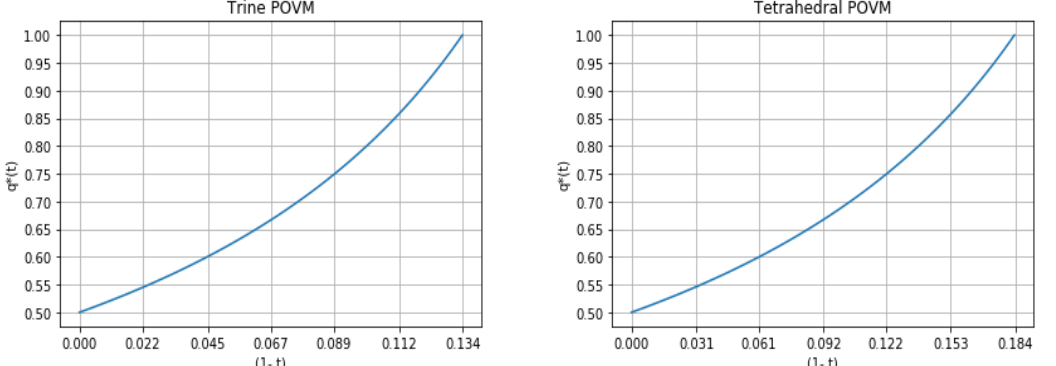
Figure 1. Plot of optimal “ SP -noise” parameter q ∗ ( M , t ) vs ( 1 − t ) for depolarized versions of two extremal qubit measurements: trine ( left ) and tetrahedral ( right